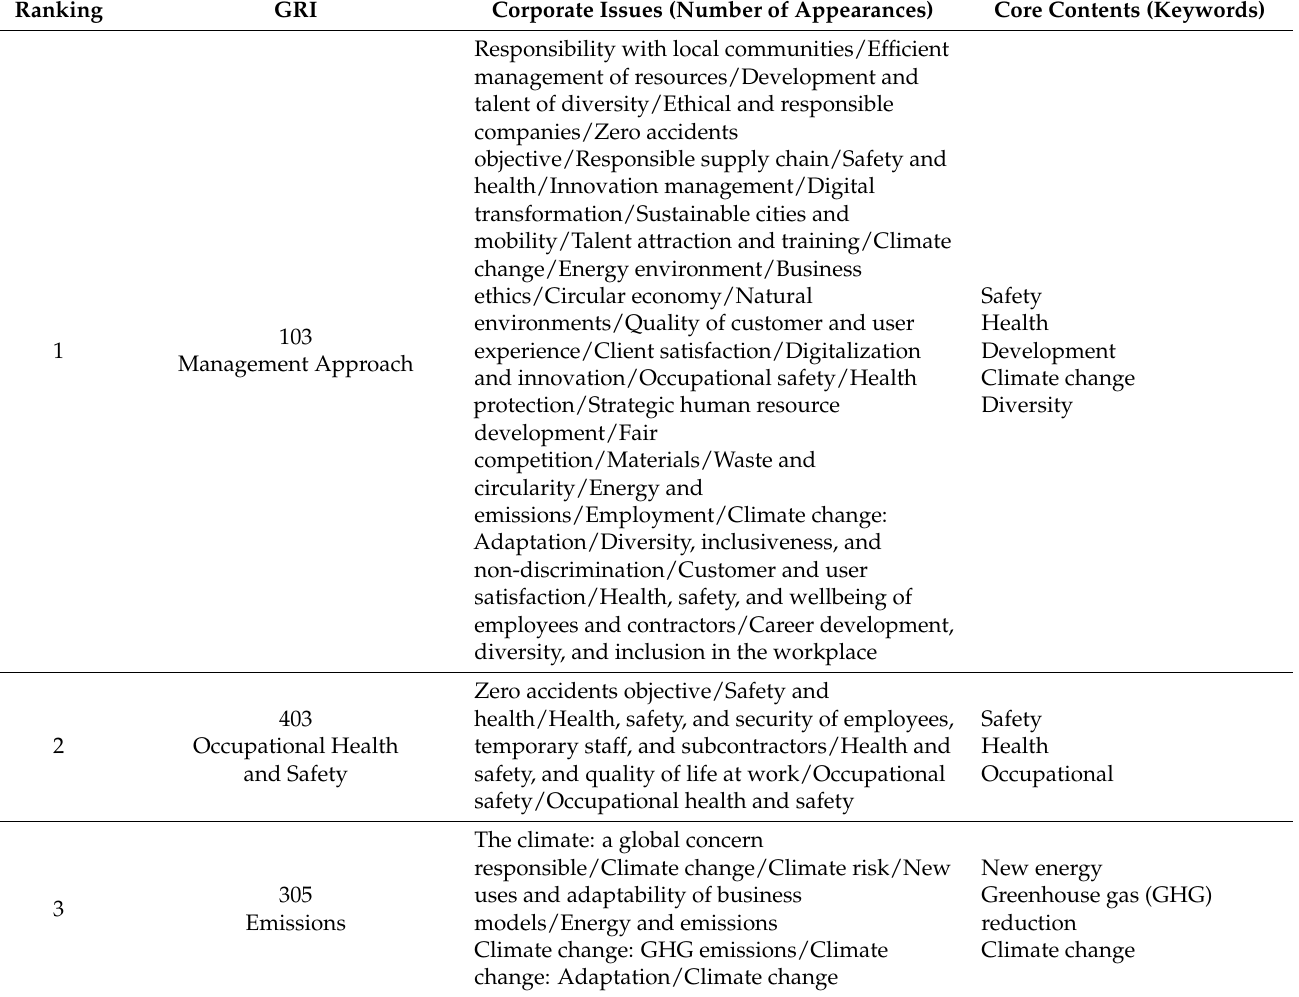
Table 11. Detailed issues and derivation of keywords from issues corresponding to the top 5 GRI codes among global construction